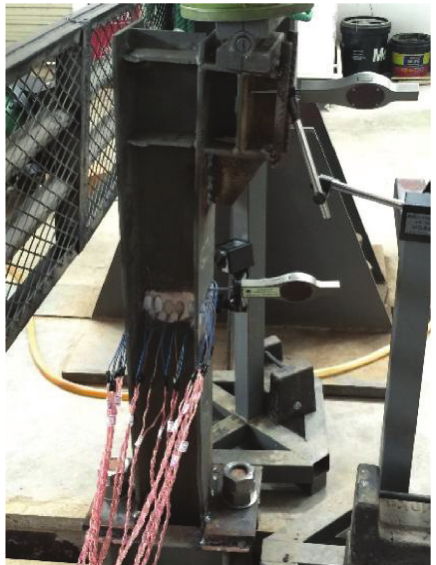
Figure 15: Photograph of the loading